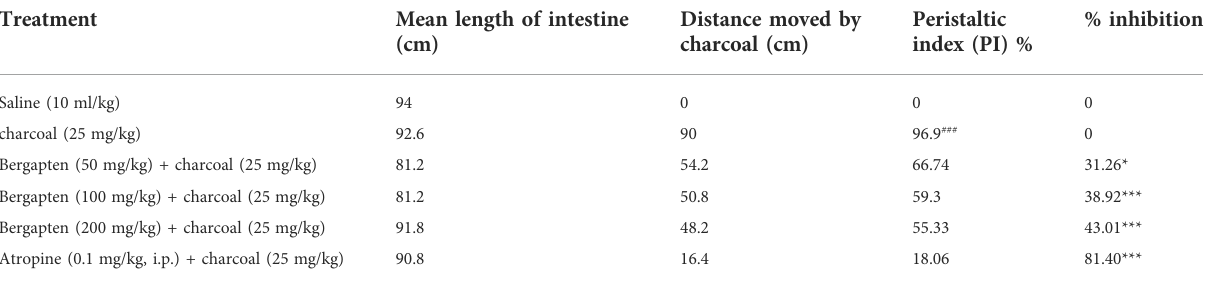
TABLE 2 Effect of bergapten and atropine on charcoal meal transit time in rats. Treatment Mean length of intestine (cm)